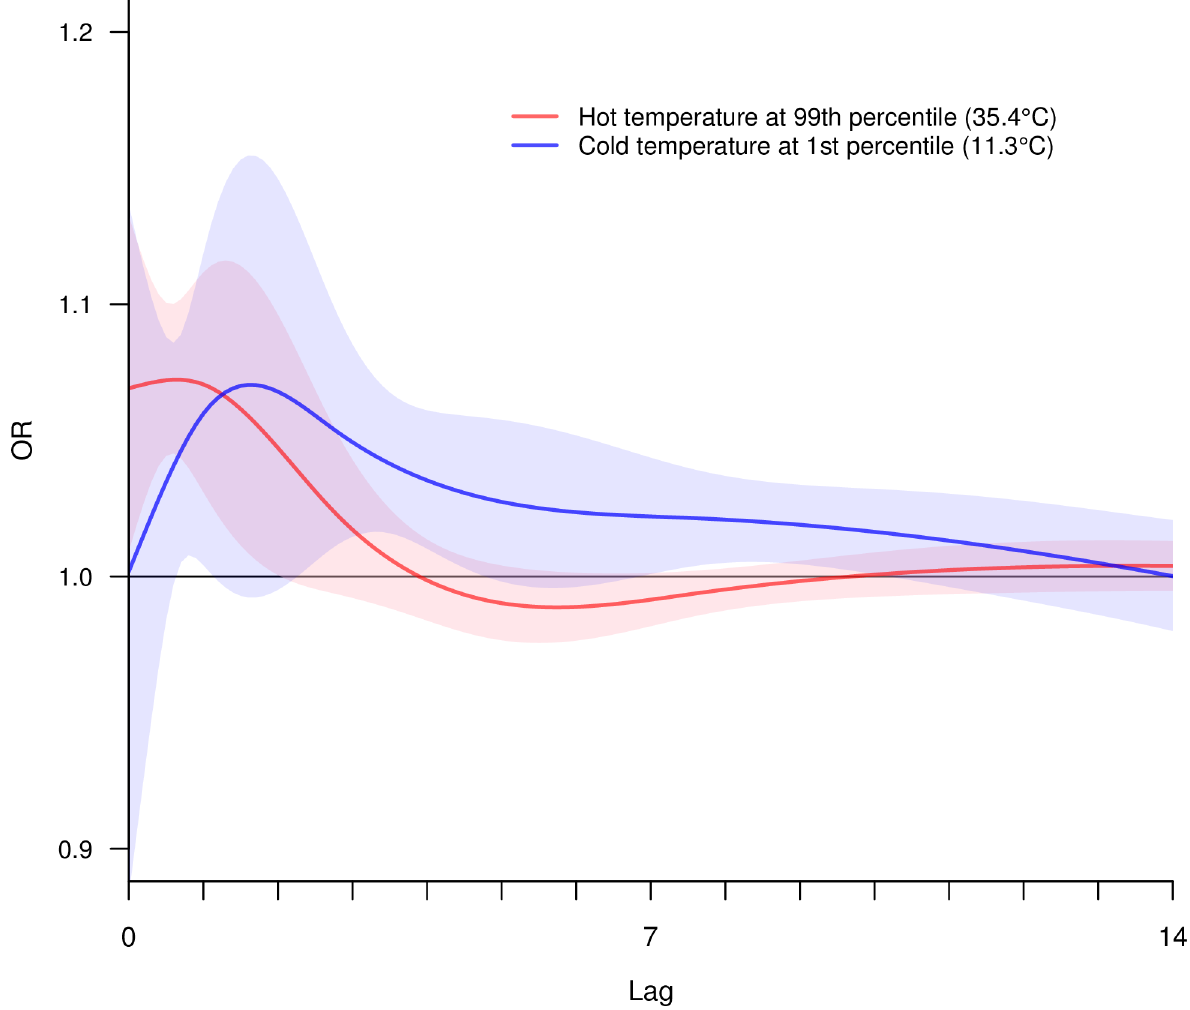
Fig 3. Lag–mortality associations from pooled estimates for medical deaths at ages 30–69 years. Solid curves represent lag–mortality associations, and shadings represent 95% CIs (red: hot temperature at 99th percentile; blue: cold temperature at 1st percentile). Graph is restricted to 0–14 lag days due to nonsignificant or negative ORs at 15–21 lag days. CI, confidence interval; OR, odds